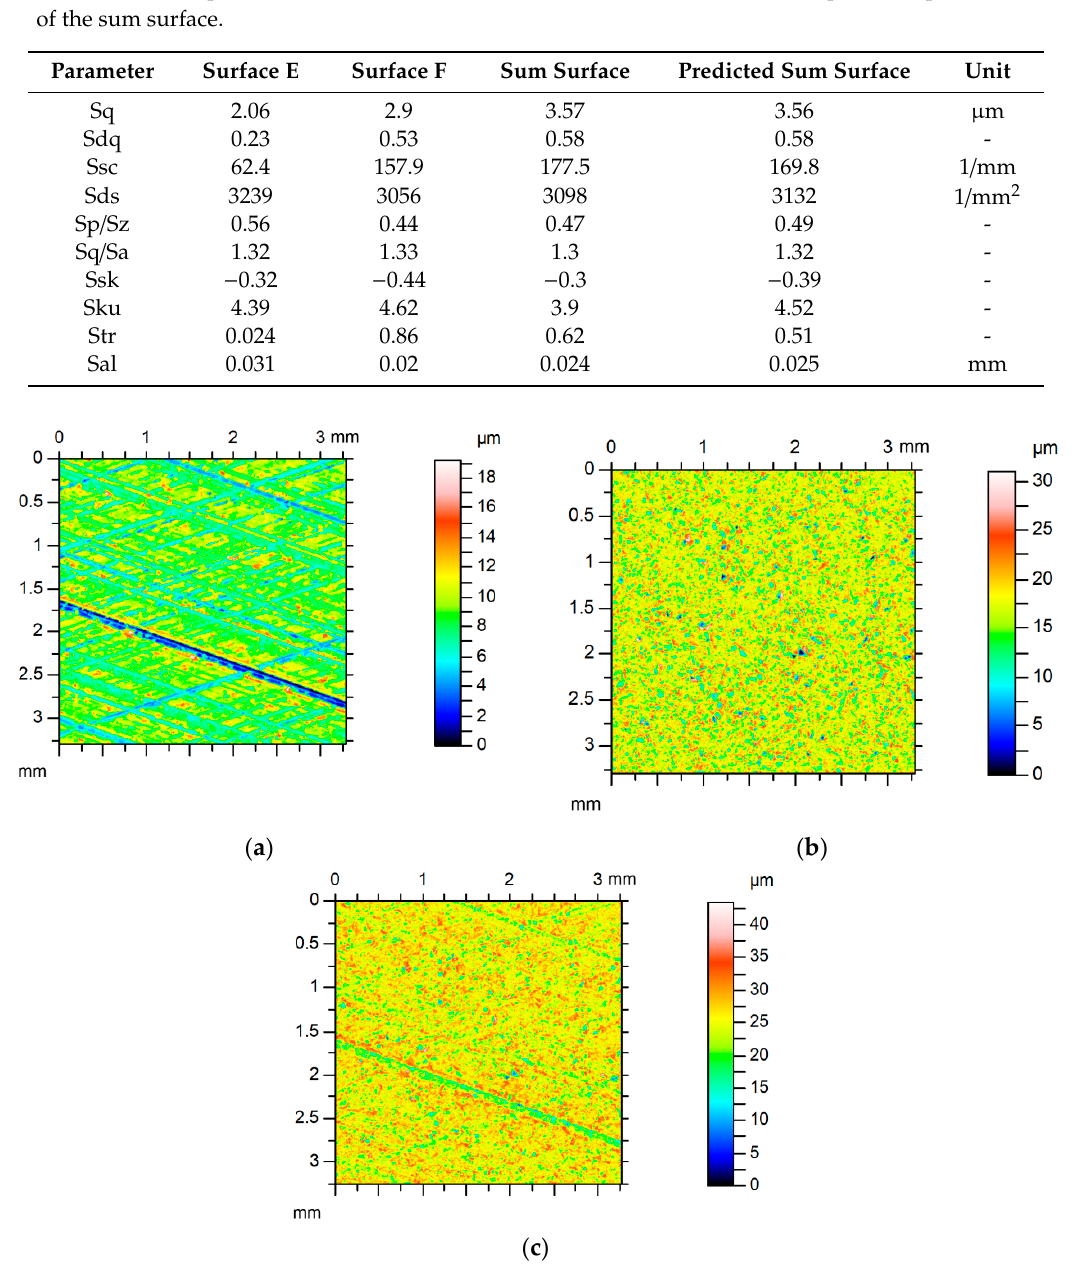
Figure 11. Contour plots of surface E ( a ), of surface F ( b ), and of equivalent sum surface ( c ).